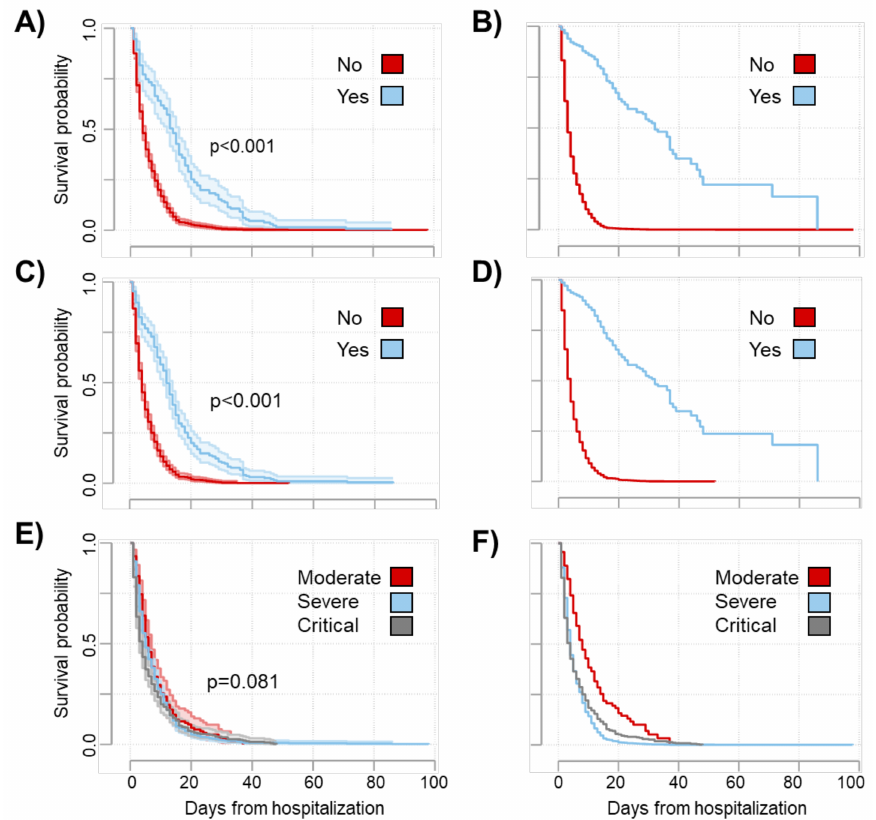
Figure 3. Kaplan–Meier curves and survival functions for deaths from COVID-19. Raw and adjusted survival functions were estimated by ICU admission ( A , B ), invasive respiratory support ( C , D ), and disease severity ( E , F ), respectively. Shaded areas represent the 95% confidence interval, and the log-rank test was used to test differences in estimated survival functions in raw analyses ( A , C , E ). Adjusted functions were constructed controlling age, sex, and